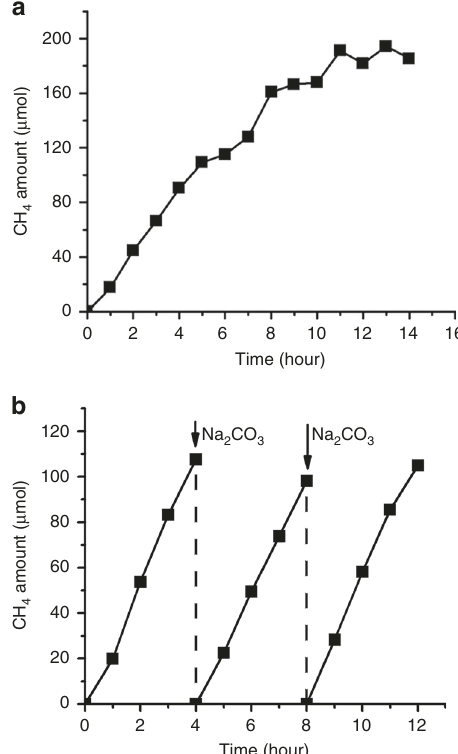
Fig. 5 Stability experiment of the ZnO-Cu 2 O catalysts. a Amount of CH 4 production using the ZnO-Cu 2 O catalysts as a function of the irradiation time up to 14h. The reaction conditions were pH = 7.4 and λ > 200 nm. The CH 4 amount was converted based on the catalyst amount fi xed to 19mg. b